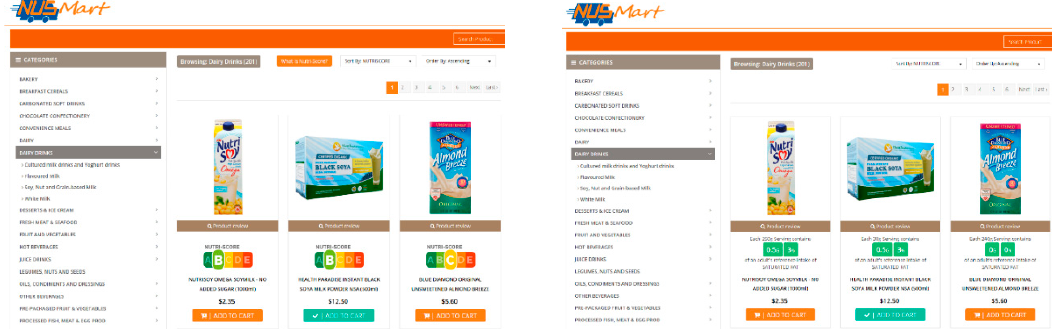
Figure 2. A screenshot of a dairy drink product listing with two different types of labels. ( Left : Nutri-Score label. Right : saturated fat label).